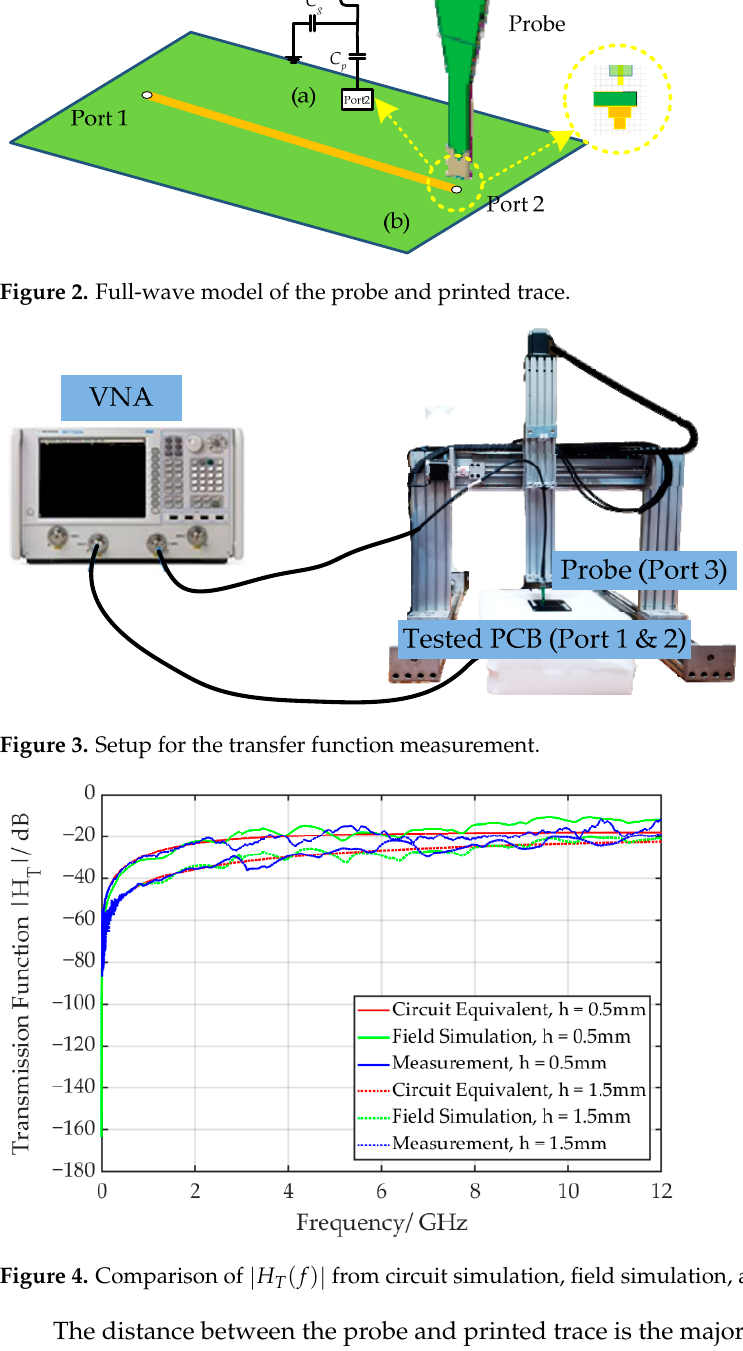
Figure 2. Full-wave model of the probe and printed trace.